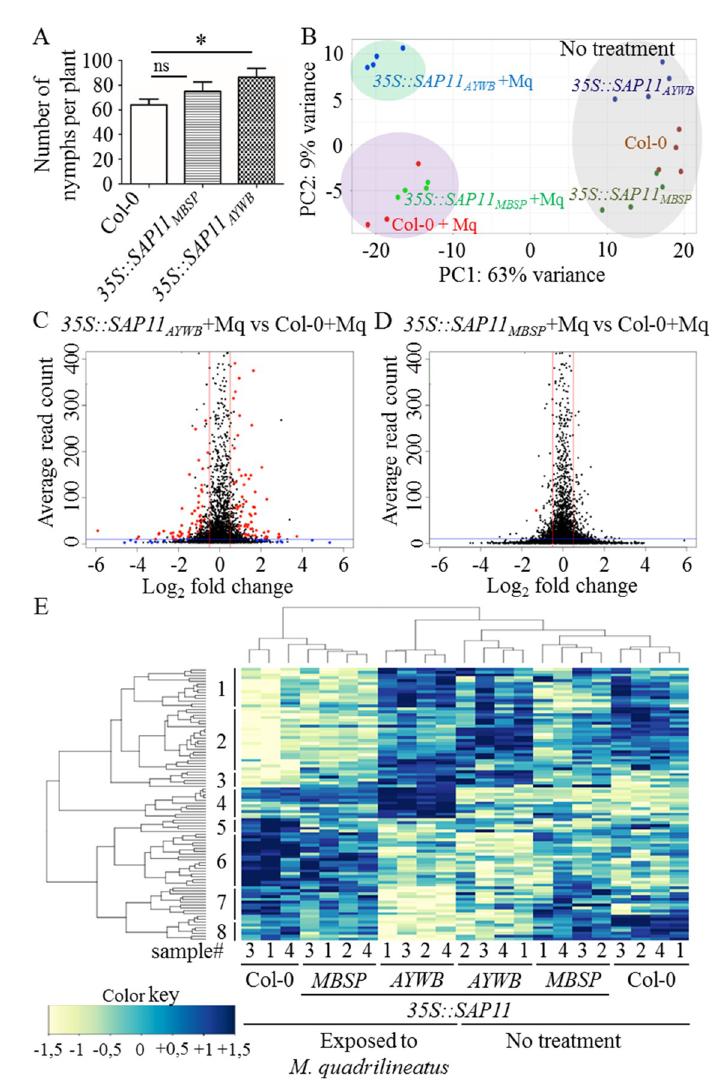
Fig 3. Analyses of the impact of phytoplasma SAP11 AYWB and SAP11 MBSP effectors on A . thaliana susceptibility to the AY-WB insect vector M . quadrilineatus . (A) SAP11 AYWB promotes M . quadrilineatus nymph production on A . thaliana , whereas SAP11 MBSP does not. Error bars denote standard errors, � p < 0.01, students t-test compared to Col-0, n = 3. (B) Principal component analysis (PCA) on the matrix of normalized read counts of 6 treatments (n = 3–4, see S1 Table) showing that SAP11 AYWB modulates plant responses to M . quadrilineatus (+Mq) differently compared to SAP11 MBSP and wt A . thaliana (Col-0). (C, D) Volcano plots showing differentially expressed genes (DEGs) in insect exposed Sap11 AYWP and SAP11 MBSP. DEGs with potential relevance in SAP11 dependent response (red dots) to M . quadrilineatus were selected by three criteria (i) P value > 0.05 (red and blue dots), (ii) average read count > 10 (dashed horizontal line) and (iii) log2 fold change > 1 (dashed vertical lines). (E) SAP11 AYWB modulates plant defence responses to M . quadrilineatus relatively to Col-0, unlike SAP11 MBSP . Hierarchical clustering based on normalized read counts of 96 selected DEGs (red dots in C). See S2 Table for normalized read count values of all treatments and S3 Table for gene annotations with 30 genes known to be involved in defence highlighted in yellow. All experiments were executed with 35S :: SAP11 AYWB line 7 [8] and 35S :: SAP11 MBSP line 1 (this work). groups based on characteristic TCP domain amino acids conserved in each of the groups, highlighted in yellow, red and green (Fig 4) [29]. In contrast to A . thaliana , maize appears to have an additional group of class II TCPs that share amino acids conserved in the TCP